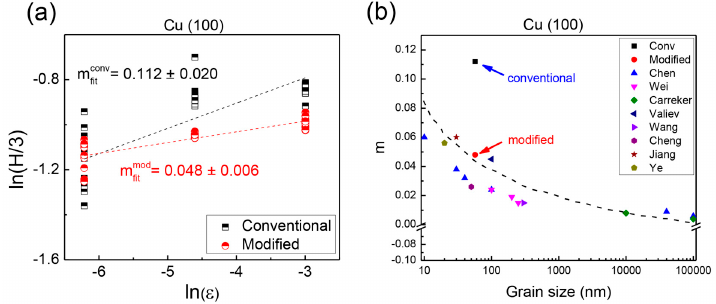
Figure 4. ( a ) The conventional method (half-filled black squares) yields erroneous SRS values for Cu. In contrast, the modified method ( half-filled red circles) produces reliable SRS values. ( b ) Compiled plots of the SRS values (m) vs. grain size obtained from various techniques, including indentation jump, tensile and compression tests for Cu. The result obtained from the modified technique is consistent with the general trend reported in the literature, in contrast to the radically different result from the conventional method.